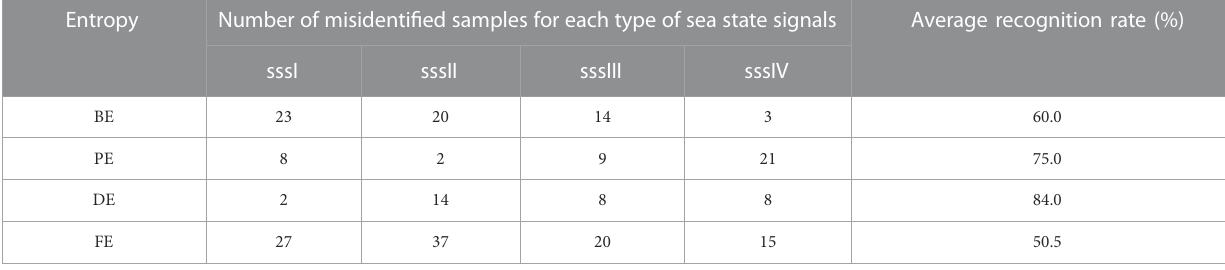
TABLE 2 Feature classi fi cation and recognition results obtained for SSSs. Entropy